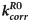
Intraobserver variability in terms of linear dependency.Linear dependency of stiffness values kR0, kcuto, knimble, kcorrR0 and kcorrcuto based on repeated measurements at each location (VF, FH, BH and LB).